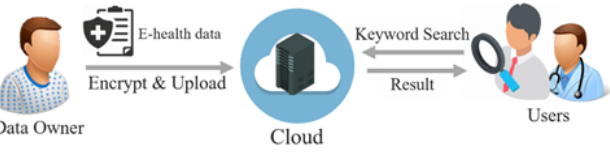
Figure 9. Overview of searchable